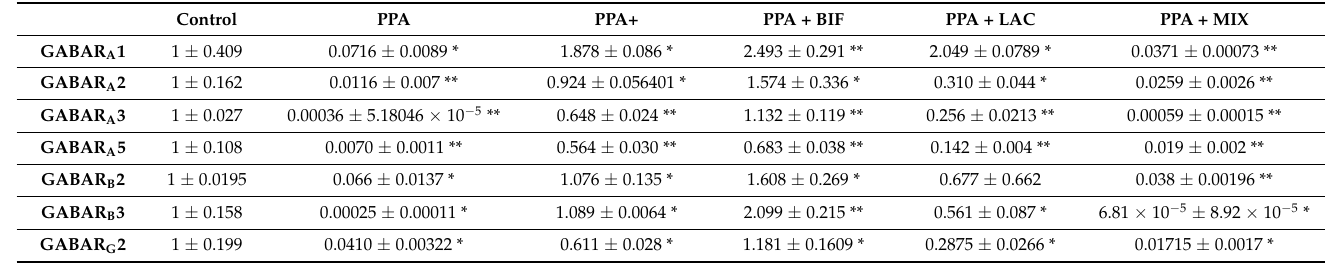
Table 3. Means ± SD of the gene expression of GABAR A , GABAR B , and GABAR G selected subunits in the brain homogenates of male western albino young rats in all groups.